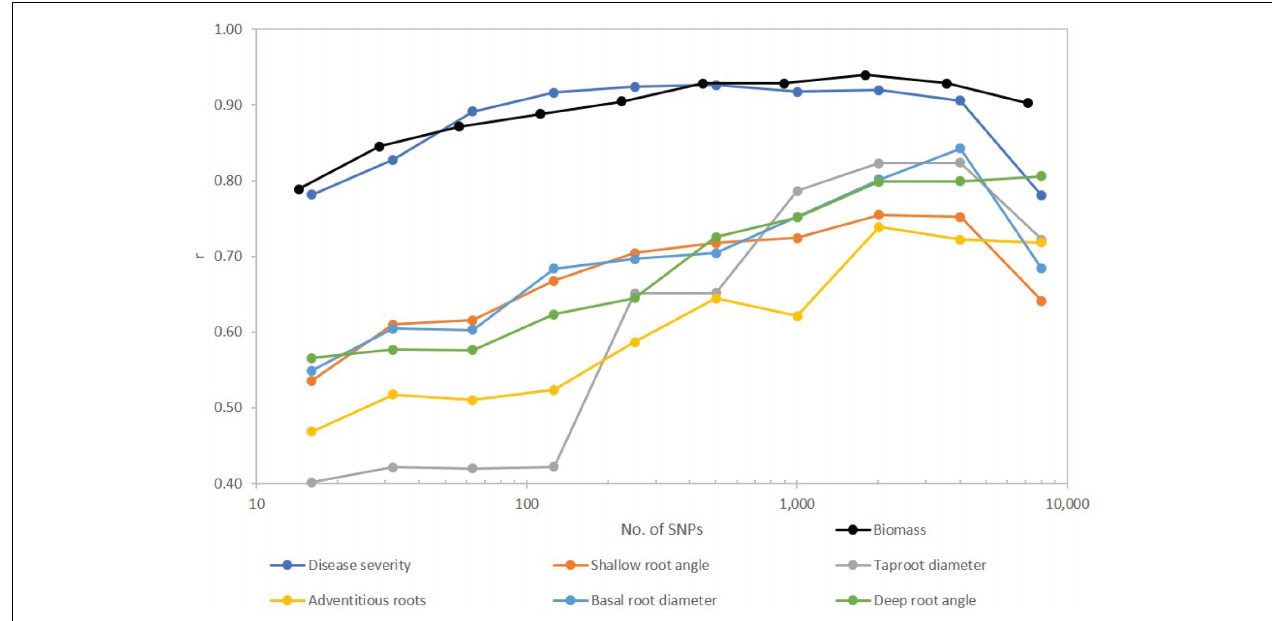
FIGURE 4 | Effect of number of SNPs on predictive accuracy for Fusarium root rot disease severity and root traits of a snap bean diversity panel. SNPs were first filtered for MAF < 0.05, then sorted from smallest to largest P value and arranged in nine subsets approximately doubling in size with each step. Full set of SNPs for biomass was 7,082 while for all other traits totaled 8,036. Number of SNPs is plotted on a logarithmic (base 10) scale.